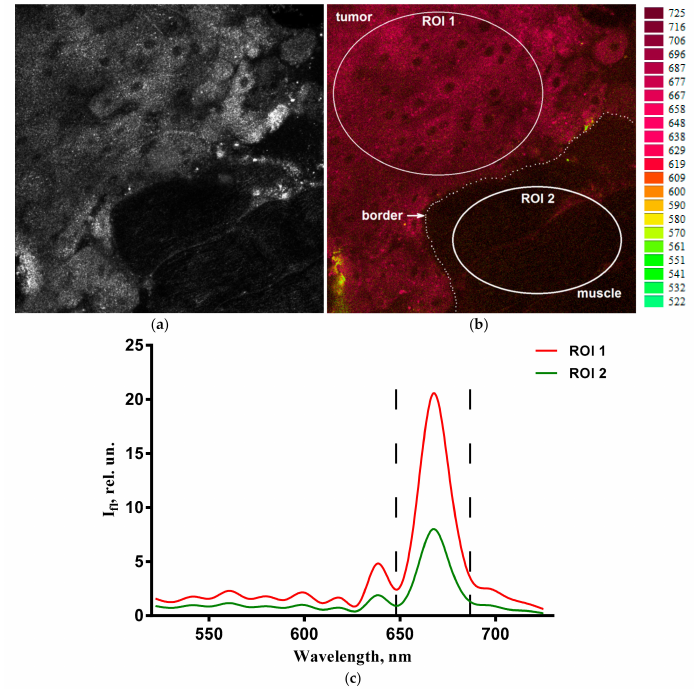
Figure 2. An example of the selection of homogeneous regions of interest (ROIs) in a fluorescence image of a tumor growing into the muscular tissue. ( a ) Reflected light image; ( b ) spectral image of the same area. Image size: 354 × 354 µ m. Dashed line depicts the boundary between tumor cells and muscle fibers that was identified using morphological features observed in the reflected light image of the scanned area. ( c ) Fluorescence spectra in ROIs selected in panel ( b ). Dashed lines in panel ( c ) restrict the 648–687 nm range that was used to calculate fluorescent intensity of CCDC in